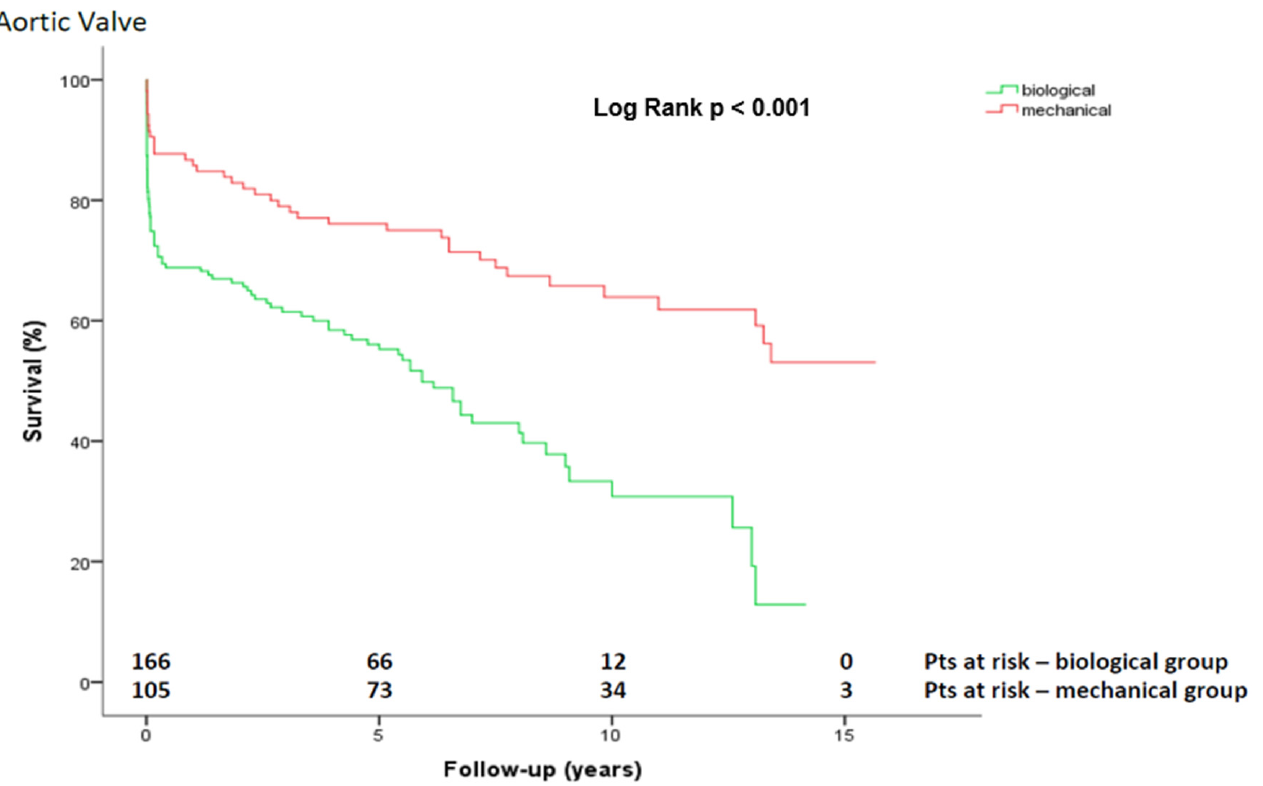
Figure 4. Kaplan–Meier curve showing survival after Bentall–De Bono operation using a biological vs. mechanical composite valve graft. Pts: patients.